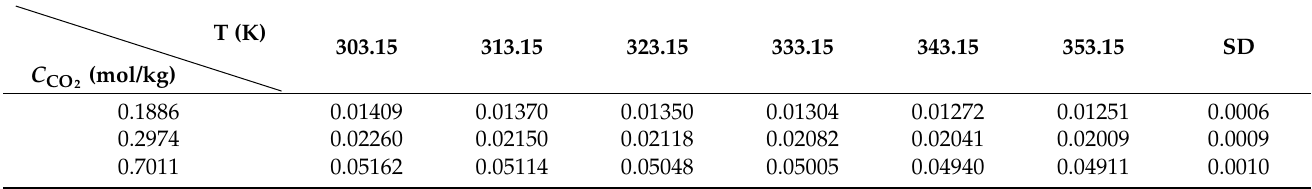
Table 5. The Raman peak intensity ratio of CO 2 + n -decane + n -hexane at different temperatures and CO 2